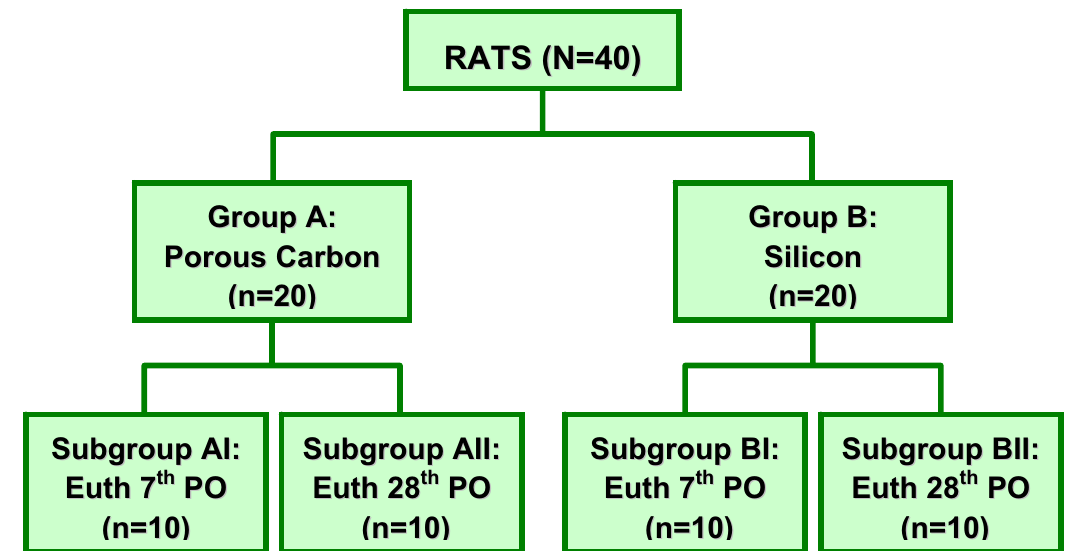
FIGURE 1 - Animals distribution in different study